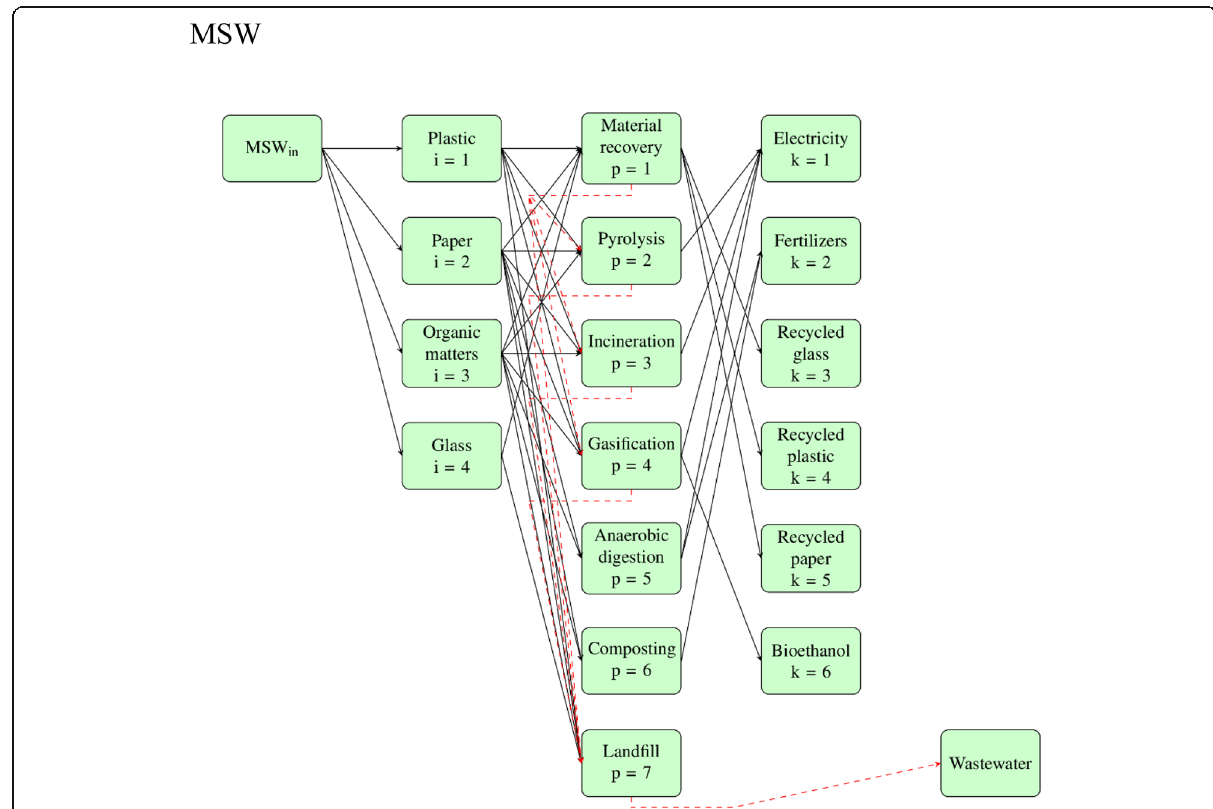
Fig. 2 Illustrative representation of the superstructure of the waste